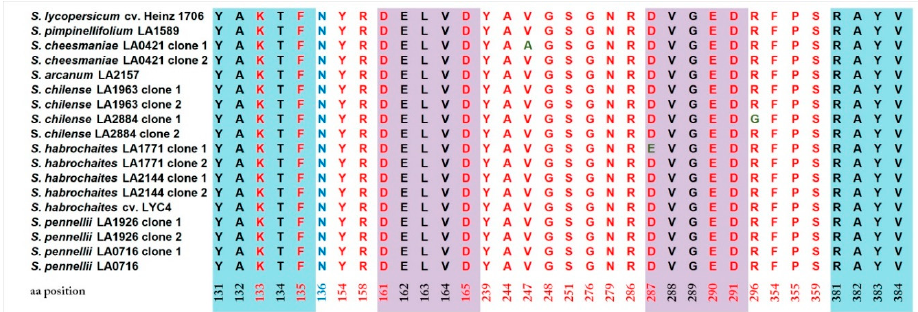
Figure 2. Functionally important sites in PSY1 -encoded proteins. Active site residues (131-YAKTF-135 and 381-RAYV384) are highlighted in blue, aspartate-enriched substrate-Mg 2+ binding sites (161-DELVD-165 and 287-DVGED-291)—violet, and additional residues that form the active site are in red font. Amino acid positions are indicated according to S. lycopersicum cv. Heinz PSY1. Position N136 (in blue font) indicates the Y136N replacement compared to C. annuum PSY1.